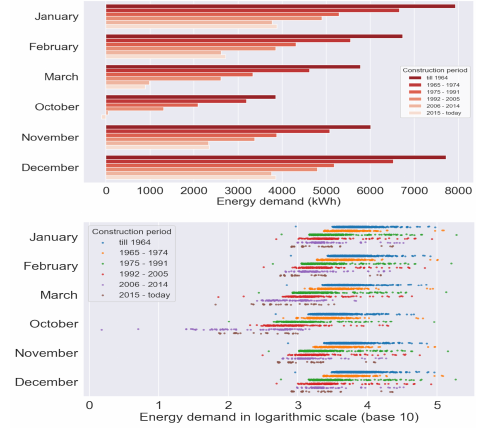
Figure 15. Average monthly energy demand (kWh) (top) and the distribution of values on logarithmic scale (bottom) for each construction period.